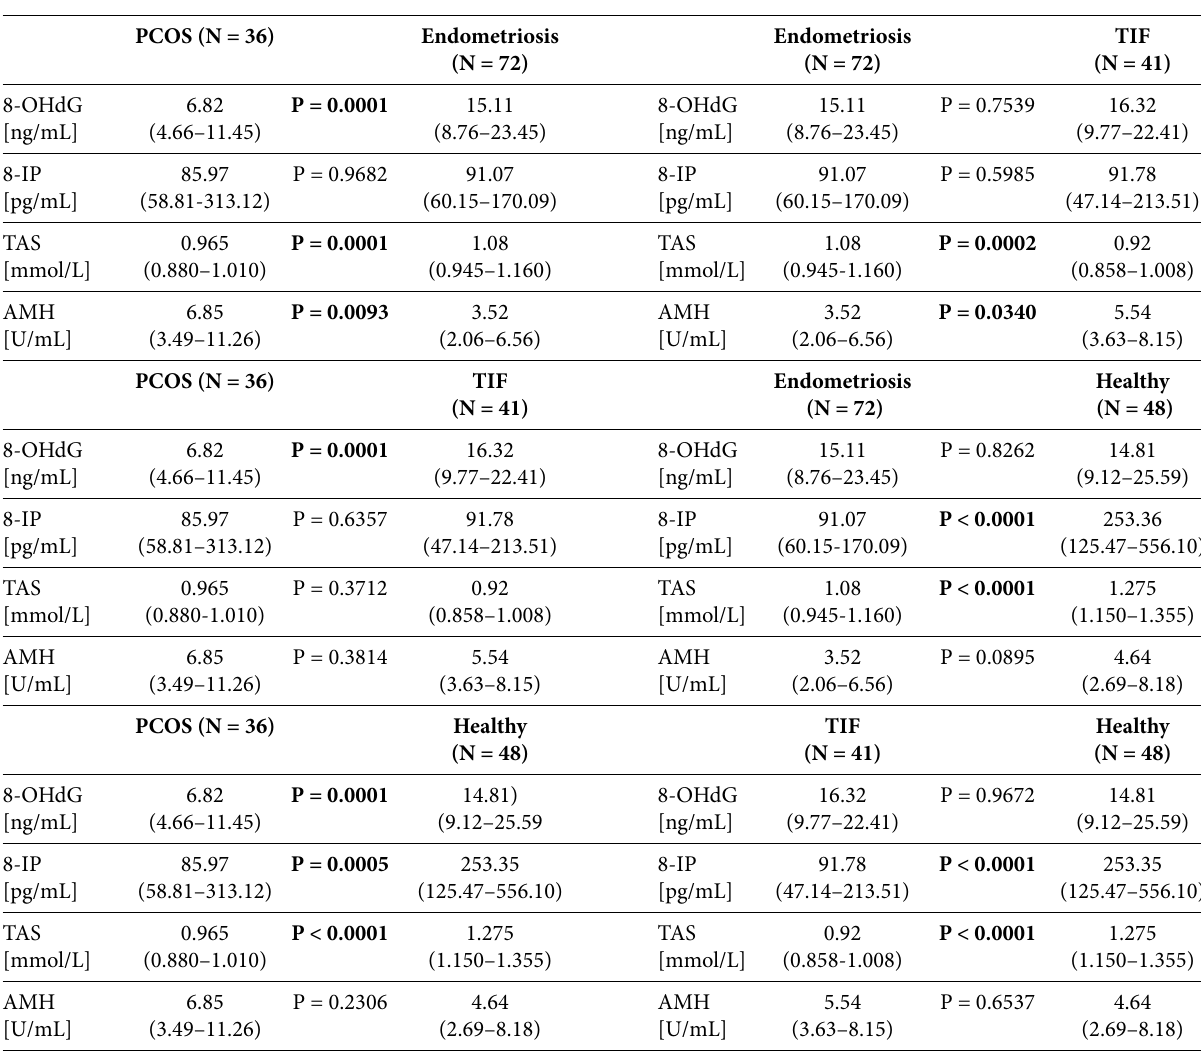
Table 4: Medians of individual biomarkers and interquartile ranges analyzed and the p values indicating the significance of differences between different groups of patients obtained by the Mann–Whitney U